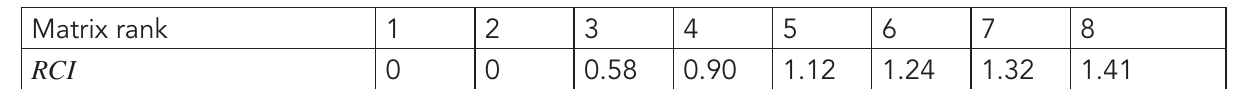
Table V: Random consistency index ( RCI )